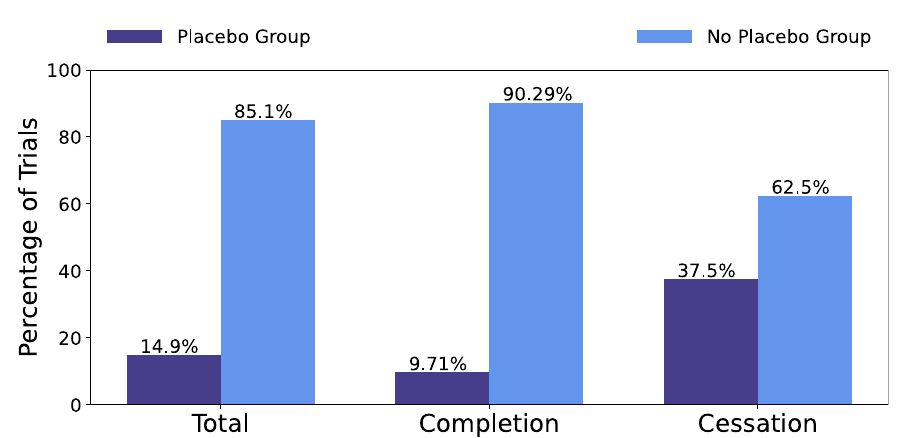
Fig 7. Distribution of trials that have a placebo group respect to all trials, completion trials, and cessation trials, respectively.